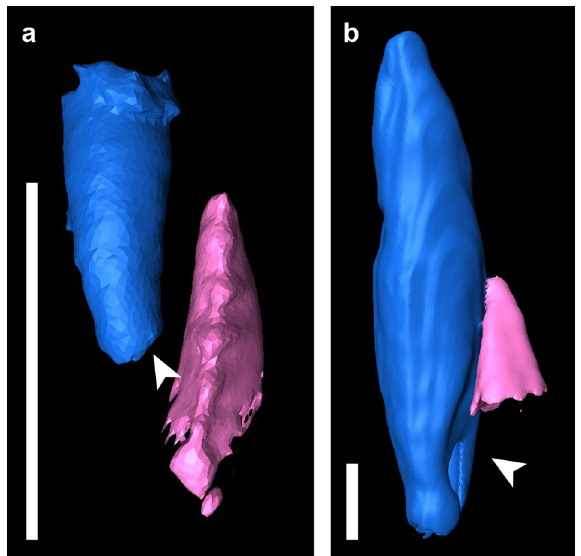
Figure 11. Segmented µCT scanned teeth in distal view showing the onset of erosion. ( a ) Niassodon mfumukasi mandibular teeth ML 1620, ( b ) Abajudon kaayai maxillary teeth NHCC LB314. The crown apex is up and lingual is to the right. Replacement teeth are highlighted in light pink and functional teeth in medium blue. White arrows indicate erosional surfaces on functional teeth. Scale bars 2 mm.